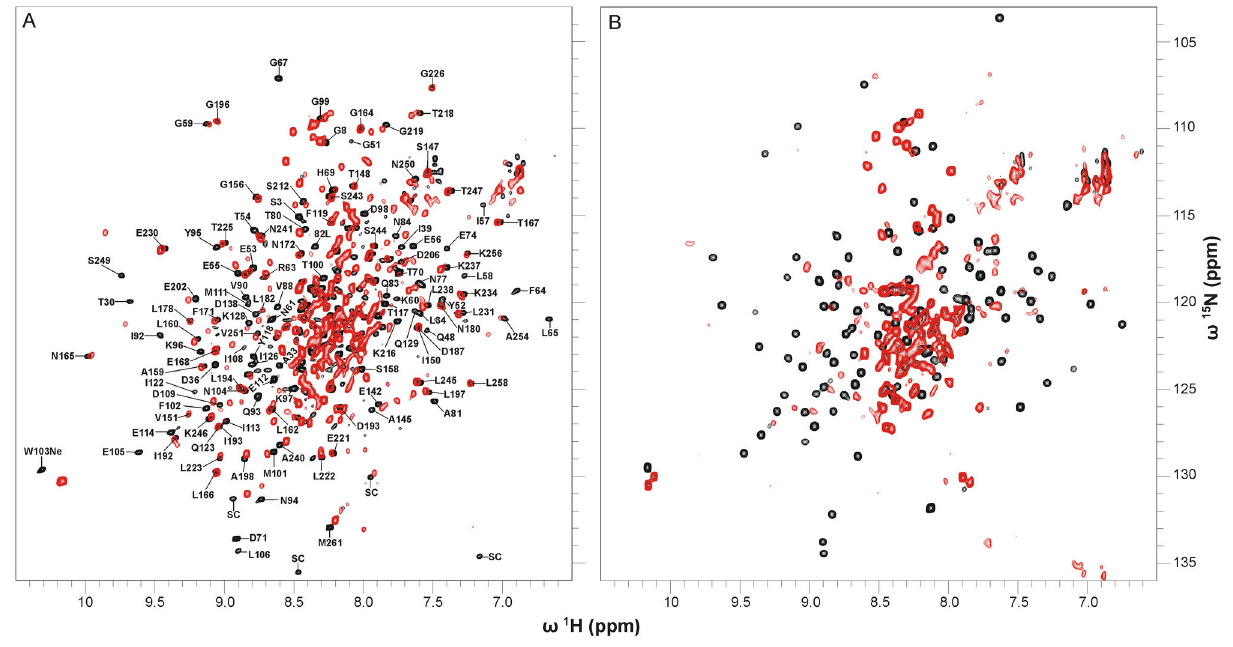
Figure 1. Superposition of 1 H- 15 N-TROSY spectra of native and apo form of YtvA and YLOV. (A) 1 H- 15 N-TROSY spectra of E.coli-YtvA (black) and Apo-YtvA (red). Both samples were uniformly 2 H- 15 N-labeled. Sequentially assigned amide resonances of E.coli-YtvA outside the central region of the spectrum are labeled with residue type and sequence position (SC: unassigned resonances most likely belonging to side chains). (B) 1 H- 15 N-TROSY spectra of E.coli-YLOV (black) and Apo-YLOV (red). Both samples were uniformly 15